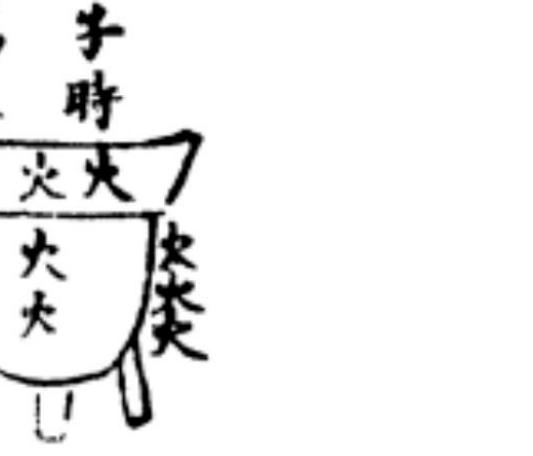
Figure 16. The method of using the tripod ( yongding fa 用鼎法 ) (Zhao 1988, p. 260c).